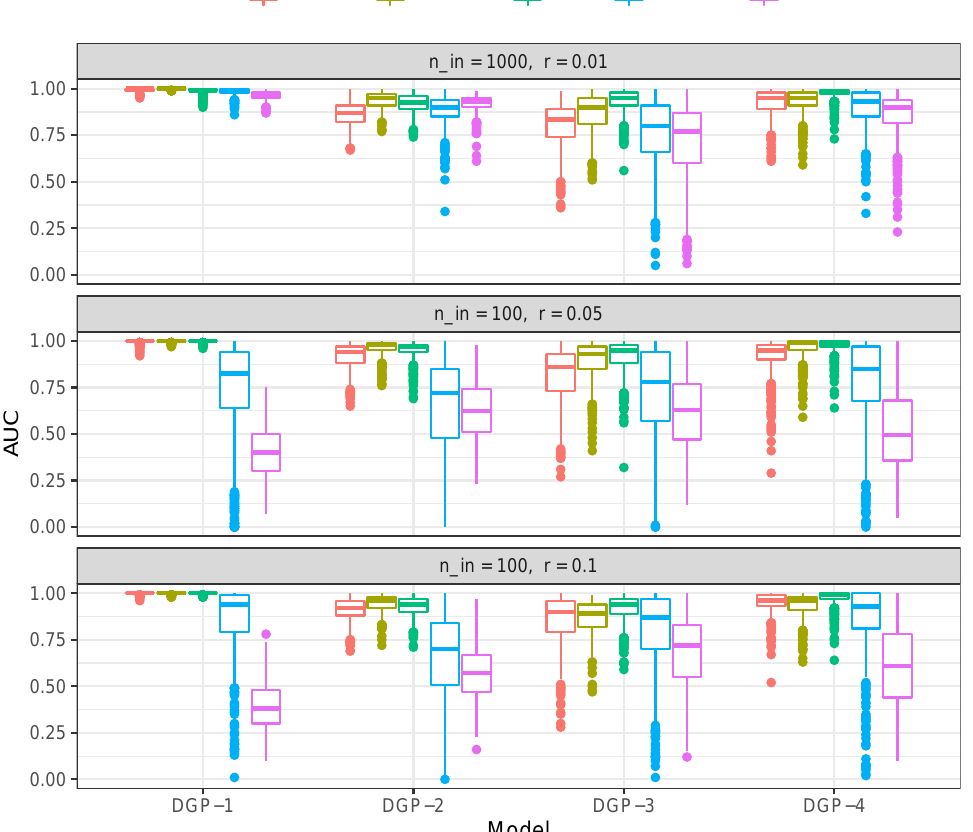
Figure 11. Comparing UMAP and ISOMAP to MDS. UMAP and ISOMAP embeddings were com- puted for two different locality parameter values: 5 and 90. The distribution of the AUC over 500 replications of the four DGPs for different outlier ratios r . The AUC computed on LOF scores based on 5D